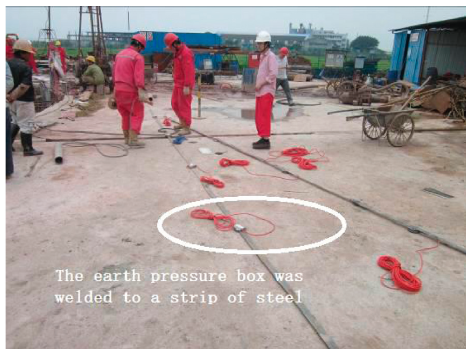
Figure 24: Installation and fixing of Earth pressure box. Figure 25: Test instrument data line protection tube installation.